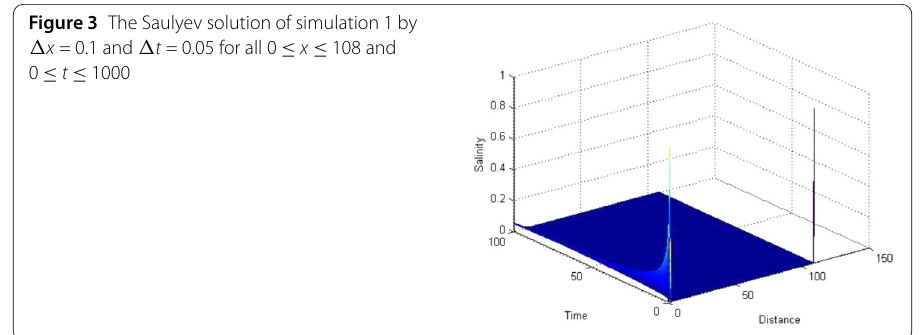
Figure 3 The Saulyev solution of simulation 1 by (cid:4) x = 0.1 and (cid:4) t = 0.05 for all 0 ≤ x ≤ 108 and 0 ≤ t ≤ 1000